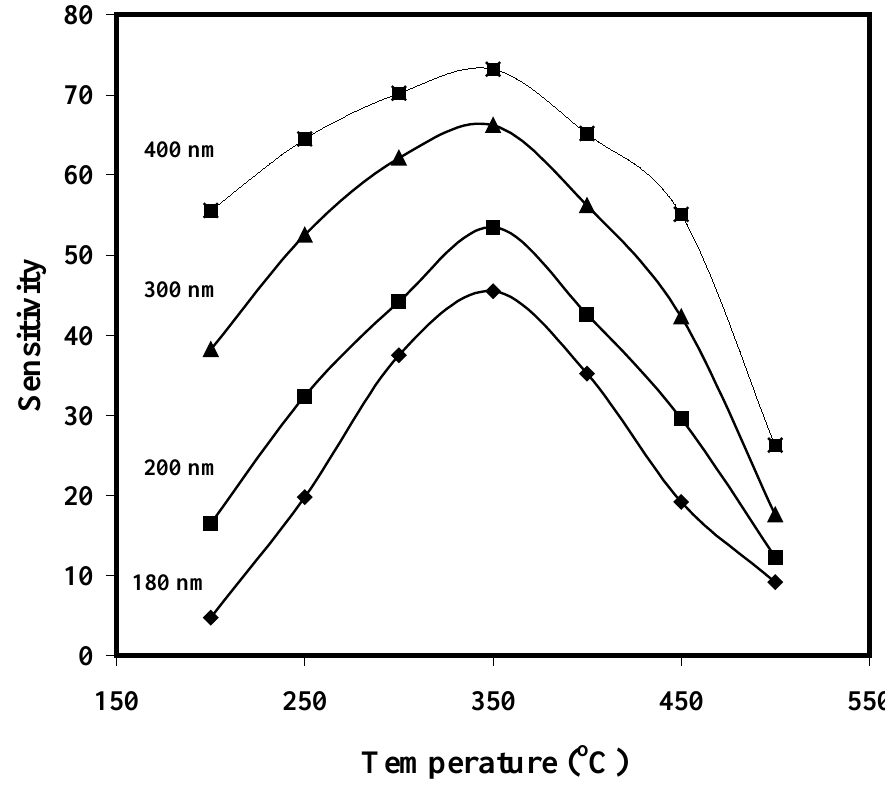
Figure 5 . Effects of film thickness of a SnO sensor on its sensitivity. The CO 2 concentration was 1000 ppm and basing voltage was 0.2